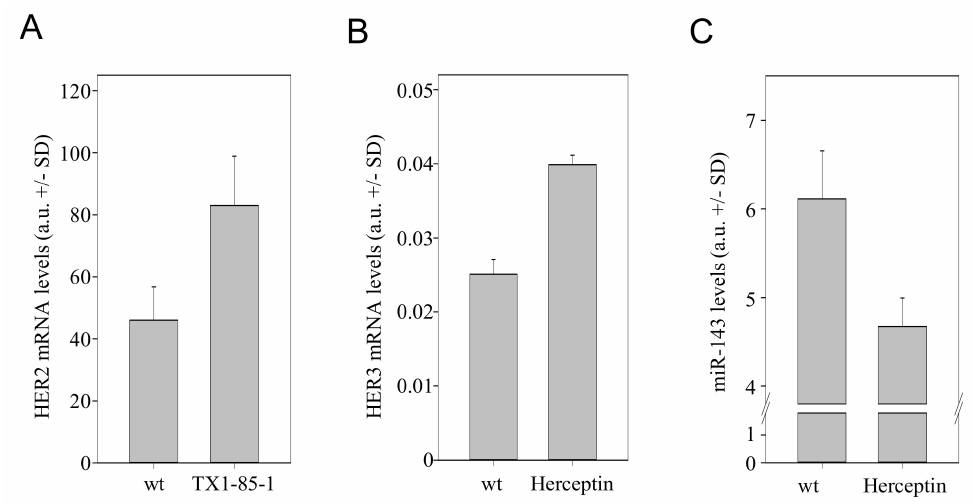
Figure 5. Effects of TX-1-85-1 or trastuzumab (Herceptin) on the HER regulation network. SKOV3 cells were analyzed for ( A ) HER2 levels upon treatment with the inhibitor of HER3 phosphorylation, TX-1-85-1, or treated with Herceptin and analyzed for ( B ) HER3 and ( C ) miR-143